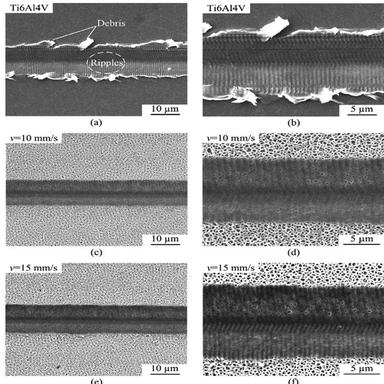
The SEM morphologies of the residual scratches obtained on (a) and (b) the original Ti6Al4V surface, as well as the surfaces with nanoporous structures obtained under different laser scanning speeds (P = 1.48 W, r = 76.6 %, f = 700 kHz): (c) and (d) v = 10 mm/s, (e) and (f) v = 15 mm/s. The scratch load is kept to 100 mN.